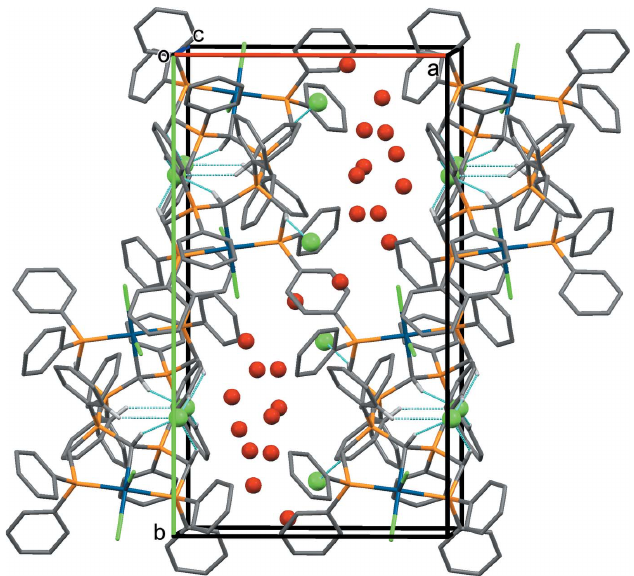
Figure 7 Aview along the c axis of the crystal packing of compound 3 . Only the H atoms involved in the most significant intermolecular interactions (Table 4) have been included. The free Cl (cid:4) anions and the disordered water molecules are shown in ball-and-stick mode.